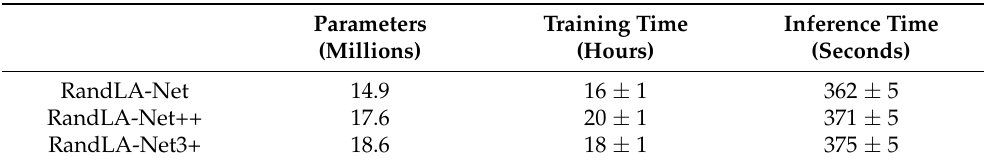
Table 4. The network parameters, training time, and inference time of different approaches for semantic segmentation using the SensatUrban [11] dataset.